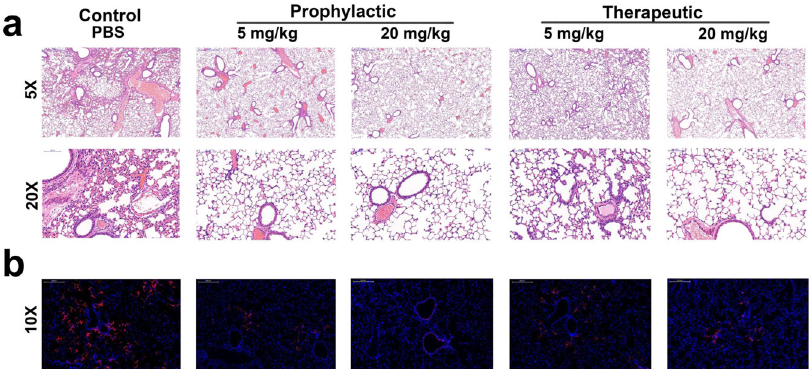
Fig. 4 Pathological changes of lung sections. a Pathological changes of H&E-stained lung sections from the prophylactic and therapeutic groups ( n = 5 mice/group). No obvious lung lesions were observed in the high-dose prophylactic groups compared with the PBS group. b Viral antigens in mice of the prophylactic and therapeutic group were tested by IFA ( n = 5 mice/group). Viral antigens (red dot) were detected by anti-2019-nCoV NP protein polyclonal antibody. Almost no obvious viral antigens were detected in the high-dose prophylactic groups compared with the PBS group, which was in accordance with the results from the H&E-staining. The images and areas of the H&E-stained sections were magni fi ed by ×5 (scale bars, 500 μ m) and ×20 (scale bars, 100 μ m). The images and areas of sections from IFA were magni fi ed by ×10 (scale bars, 200 μ m).